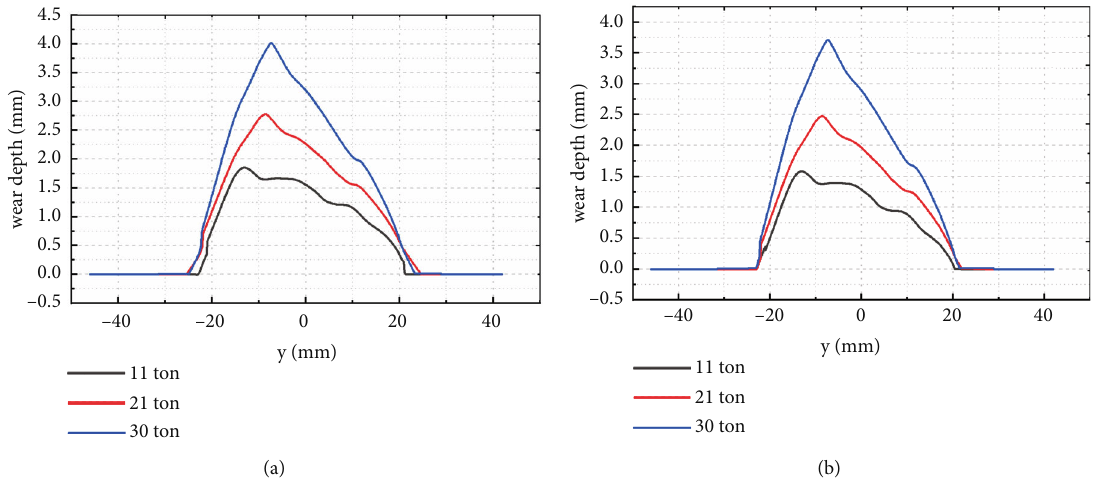
Figure 8: In fl uence of load on the wear depth of wheel material; (a) normalized UIC 50 kg/m rail and S1002 wheel pro fi le and (b) hardened U UIC 60 kg/m and S1002 wheel pro fi le.